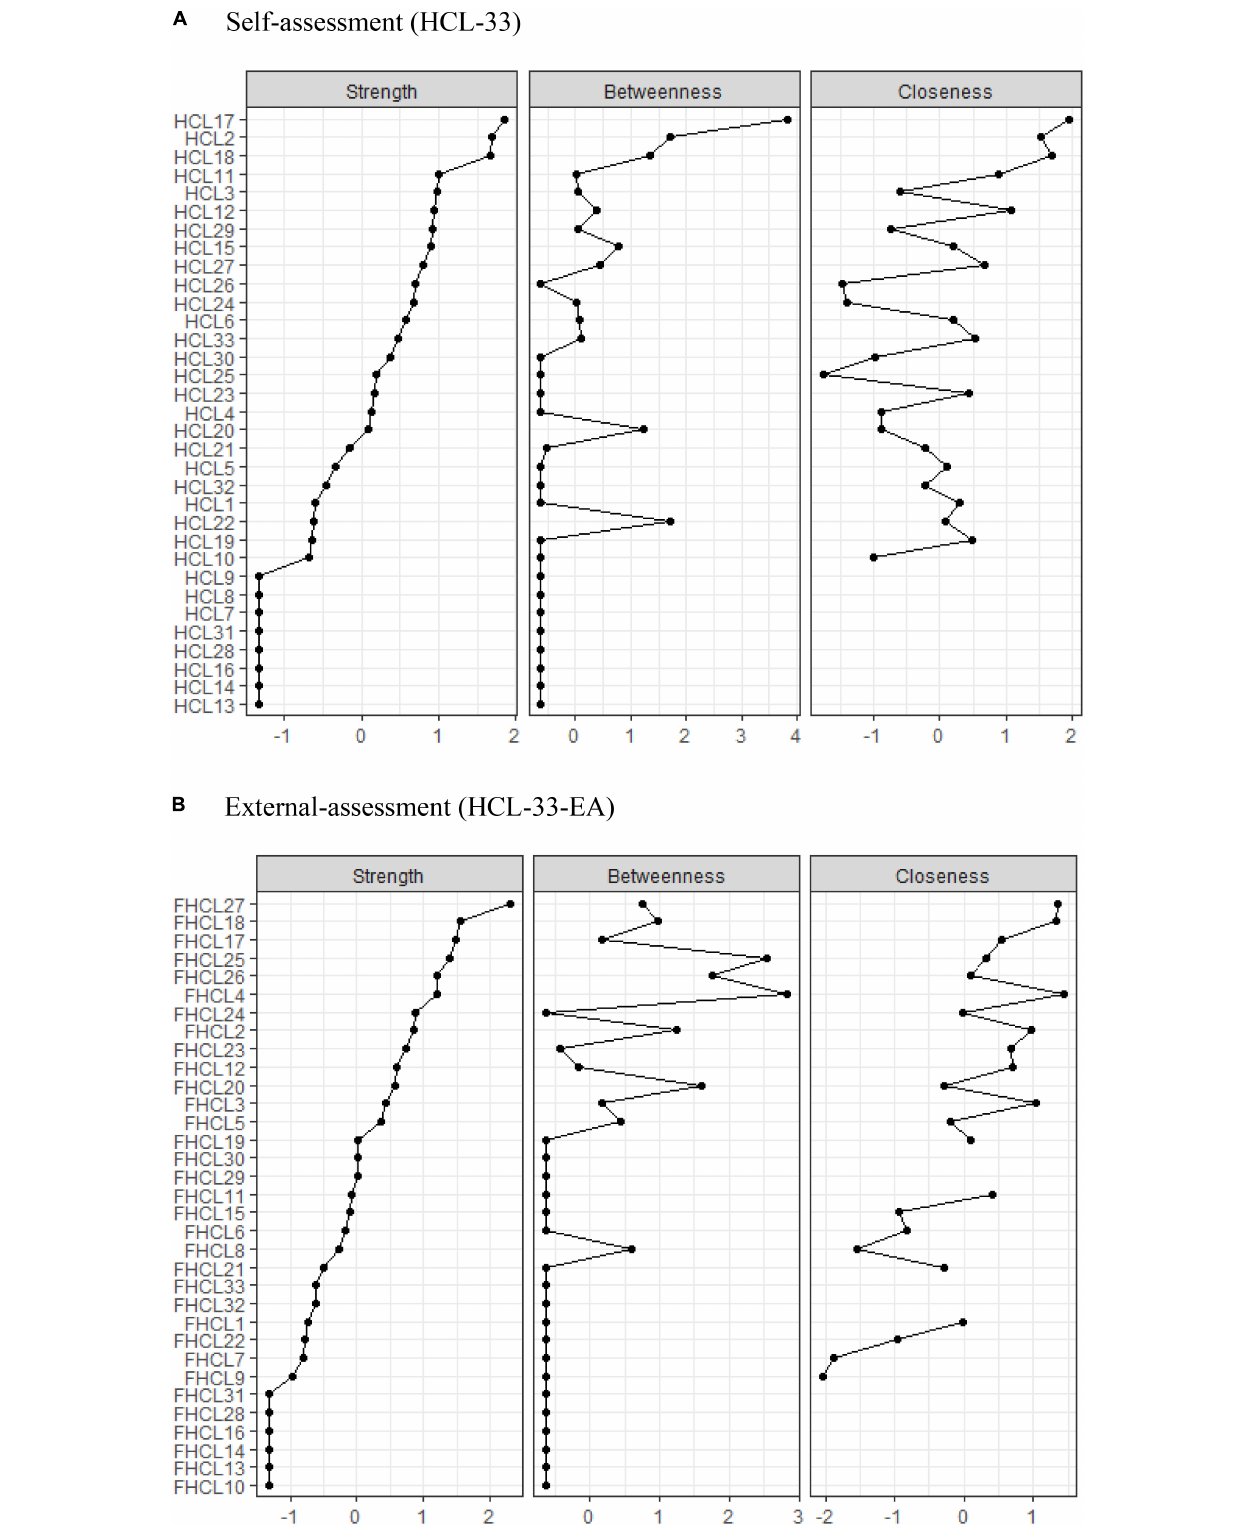
FIGURE 2 | Comparison of the centrality indices between HCL-33 (A) and HCL-33-EA (B) . HCL-33, the 33-item Hypomania Checklist (self-assessment version); HCL-33-EA, the 33-item Hypomania Checklist (external assessment version).